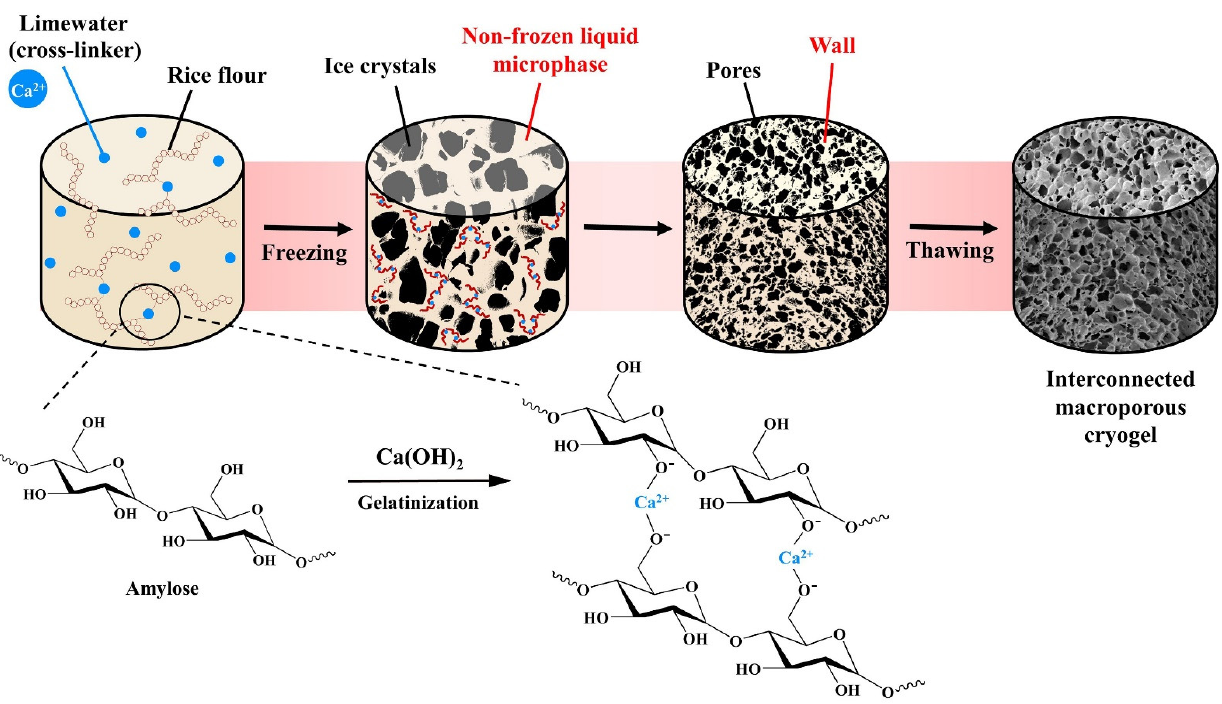
Figure 4. Proposed mechanism of synthesis of the